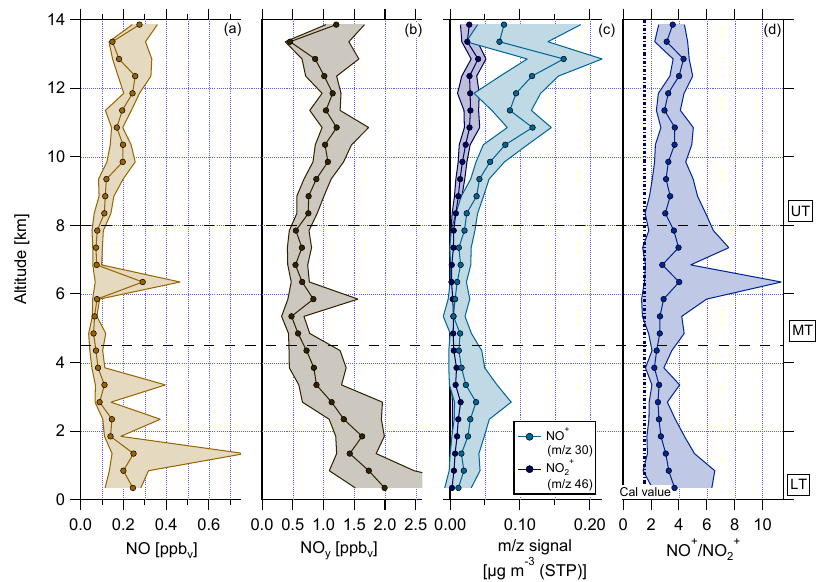
Figure 9. Vertical profiles of (a) NO mixing ratio, (b) reactive nitrogen NO y mixing ratio, (c) NO + ( m/z 30, light blue) and NO + dark blue) mass signal, and (d) ratio of NO + ( m/z 30) to NO + MT, and UT. The vertical dashed line in (d) presents the ratio of NO + to NO +